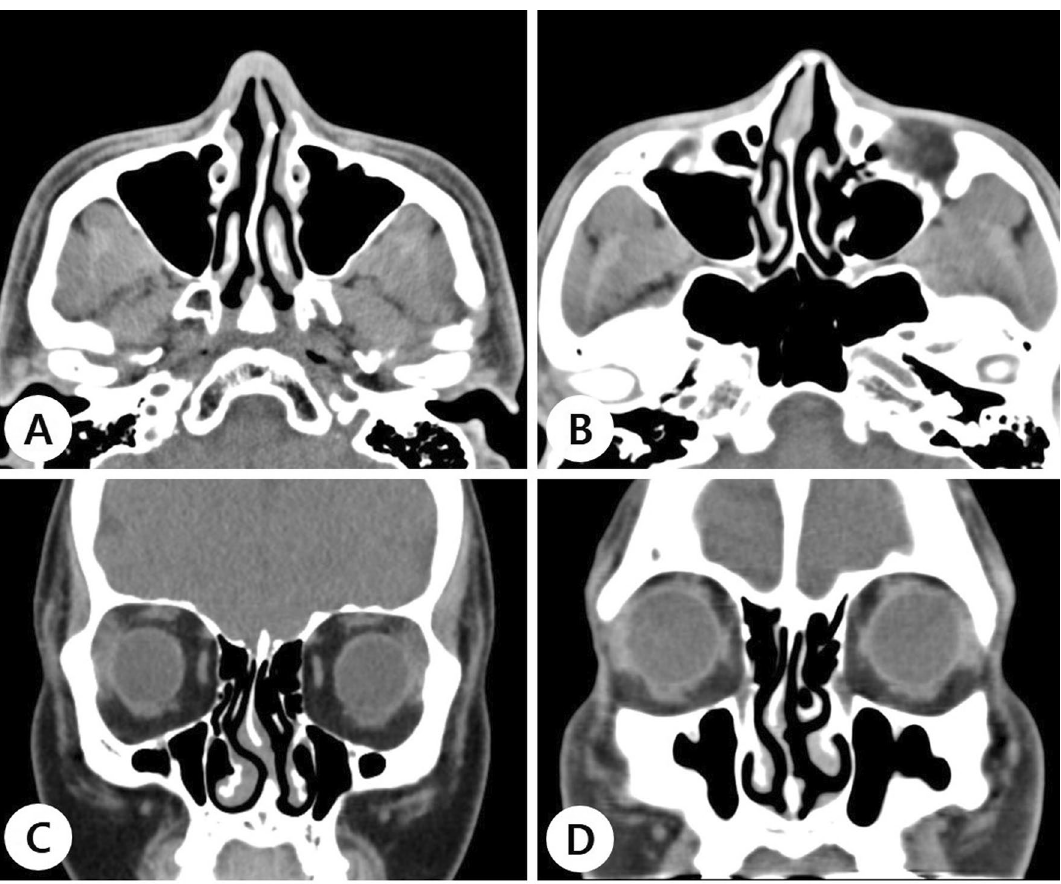
Figure 1. Types of nasal septal deviation. Axial ( A , B ) and coronal ( C , D ) computed tomography images reveal S- ( A , C ) and C-shaped ( B , D ) deviations in the anteroposterior and cephalocaudal directions,